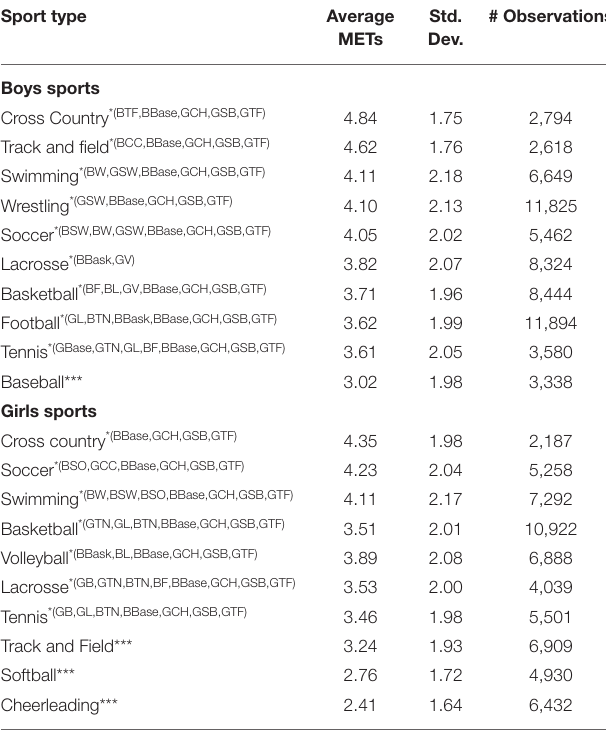
TABLE 2 | High School Sports Ranked on Average METs PER